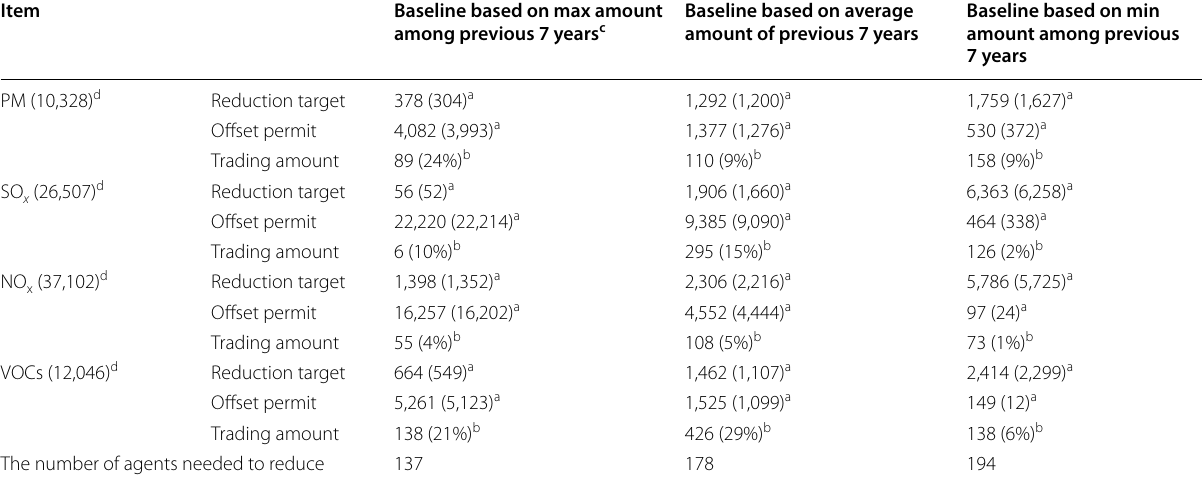
a The number inside the parentheses indicates the simulation amount after trading b The number inside parentheses indicates trading ratio c Baseline setting is original baseline of the emission cap-and-trade program rules d Pollutant annual emission